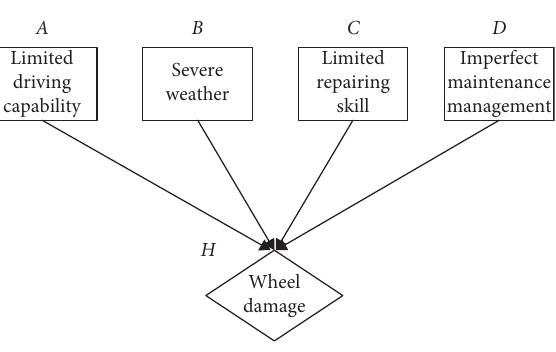
Figure 8: Final influence diagram. Table 8: Priori and conditional possibility